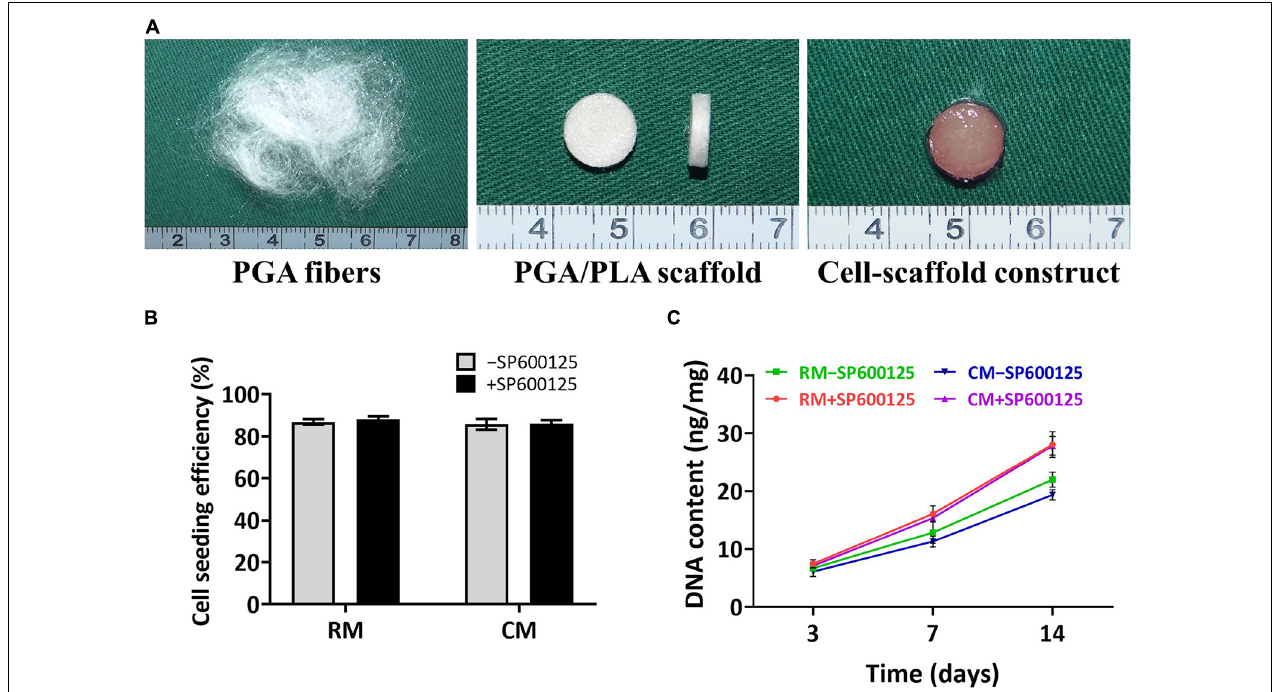
FIGURE 3 | Preparation of in vitro constructed cartilage and biocompatibility of scaffolds. Unwoven PGA fibers were compressed into PGA/PLA scaffolds 9 mm in diameter and 2 mm thick, and then rabbit auricular chondrocytes were seeded into each scaffold to form cell-scaffold constructs (A) . There were no significantly differences in cell seeding efficiencies among each group (B) . DNA content (C) of each group was enhanced with culture time. Treatment with SP600125 resulted in an increase of DNA content, while treatment with CM inhibited the growth of DNA content. However, the CM + SP600125 group showed that adding SP600125 reversed this inhibitory effect of CM and resulted in more DNA content. PGA, polyglycolic acid; PLA, polylactic acid; RM, regular medium; and CM, chondrogenic